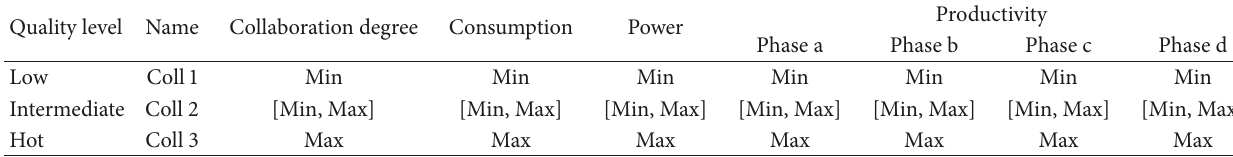
Table 4: Example of collaborators configurations.